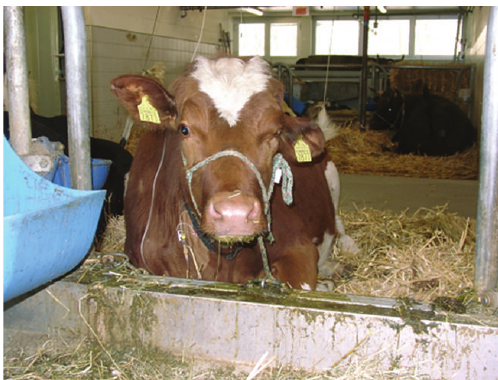
Figure 2: Recumbent goat with rhombencephalitis due to Listeria monocytogenes infection. The animal has a head-tilt and pleurotho- tonus; its right ear is drooping.